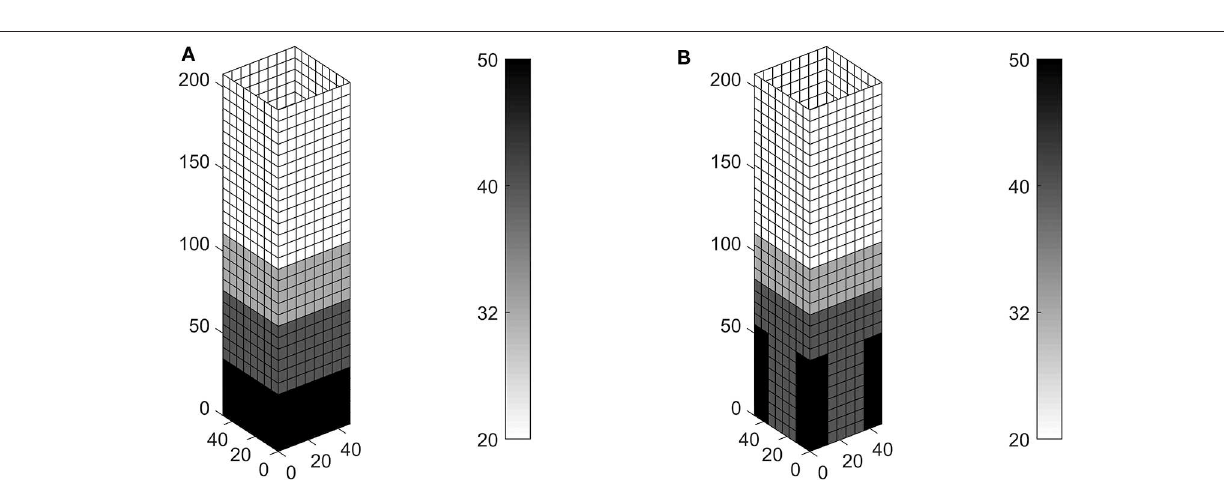
FIGURE 7 | Optimal thickness (mm) in the diagrid of a tall building with square plan, using four circular hollow cross-sections with φ elements, W 28,891kN; (B) patch with 2 =